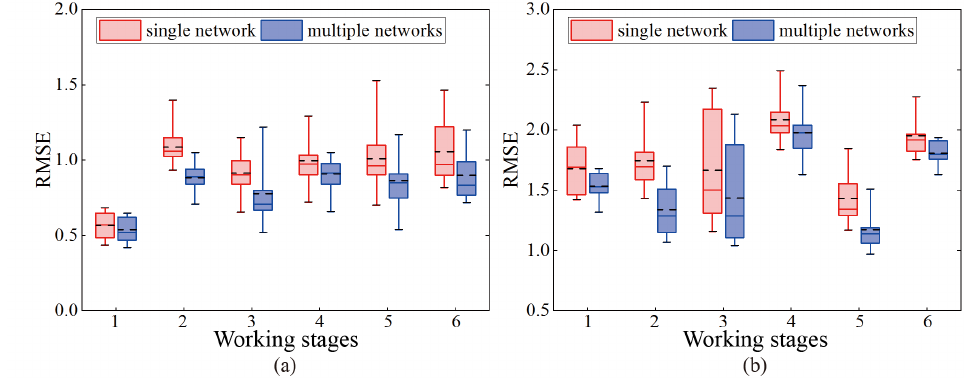
Figure 10. RMSE comparison of different LSTM networks using small coarse gravel: ( a ) prediction of throttle value ( b ) prediction of